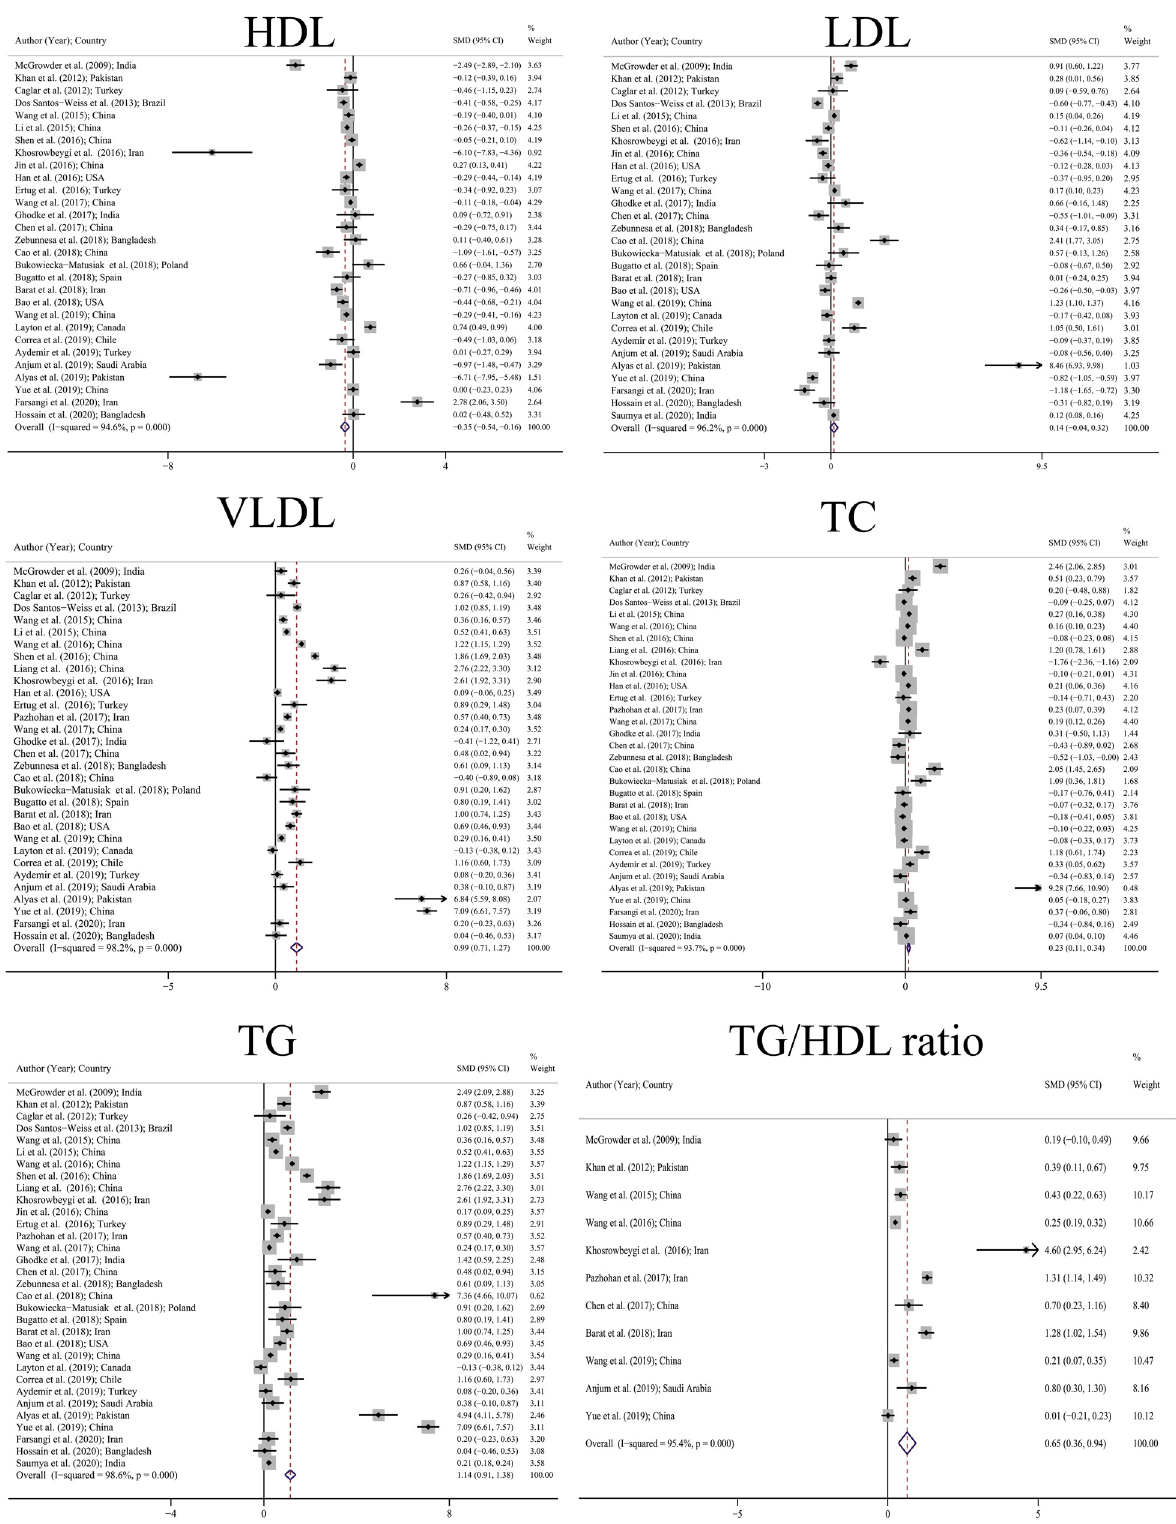
Figure 2: Pooled SMD of lipid pro fi le based on random e ff ects model. The midpoint of each line segment shows the SMD, the length of the line segment indicates 95% con fi dence interval in each study, and the diamond mark illustrates the pooled SMD for di ff erent lipid pro fi